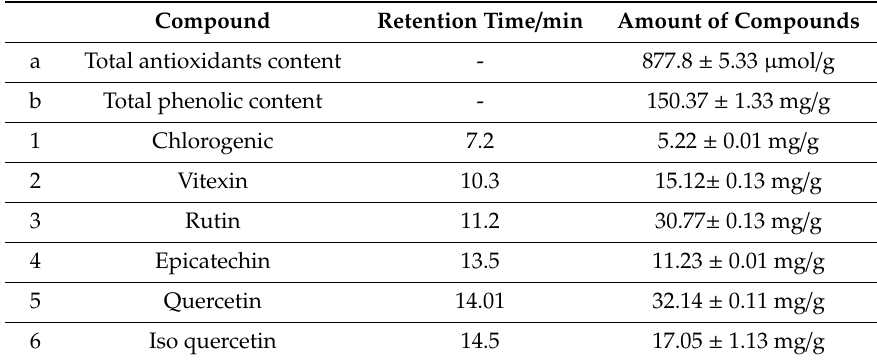
Table 2. Amount of total antioxidant a phenolics b , and the qualitative–quantitative analyses of phenolic compounds of HAW extract carried out using an HPLC.